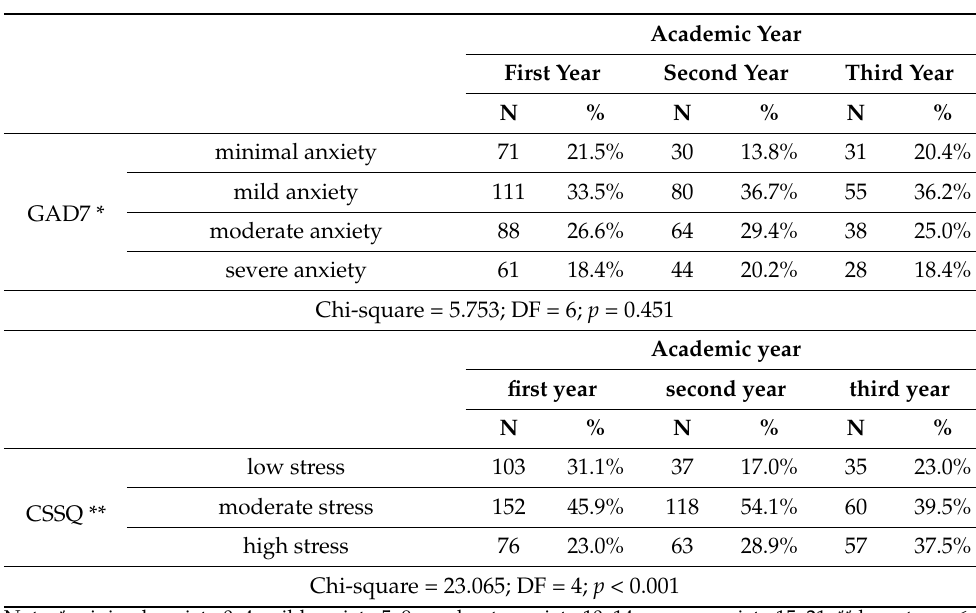
Table 4. Frequency distribution for Academic year about the psychological health